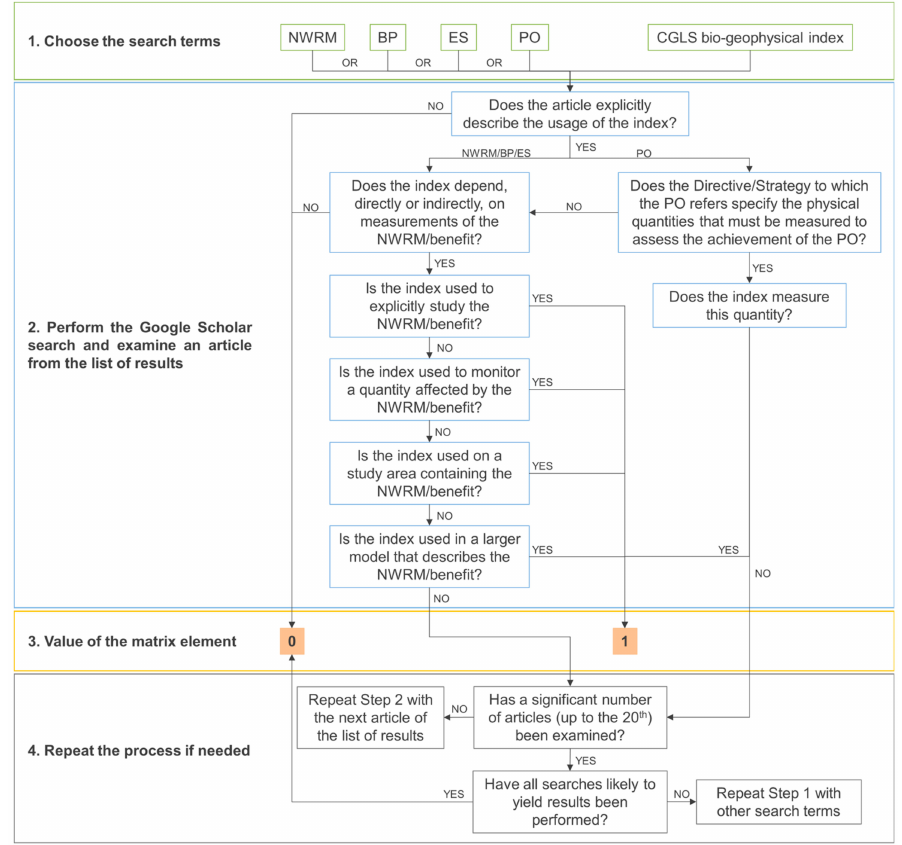
Figure 2. Flowchart of the followed procedure to perform each query and ascertain whether a given article was valid and e ff ectively proved the existence of an actual or possible link between a bio-geophysical index and a NWRM, BP, ES, or